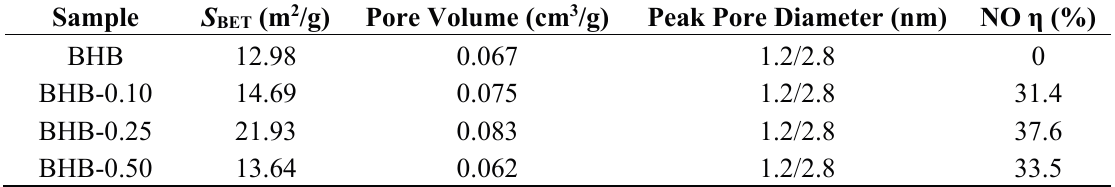
Figure 5. N 2 adsorption-desorption isotherms ( a ) and pore size-distribution curves ( b ) of BiOCOOH and BHB-X. Table 1. The S BET , pore volume, peak pore diameter, NO removal ratio of the samples.